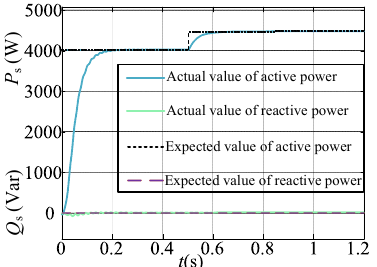
Figure 10. DFIG output power at rotor speed jump.